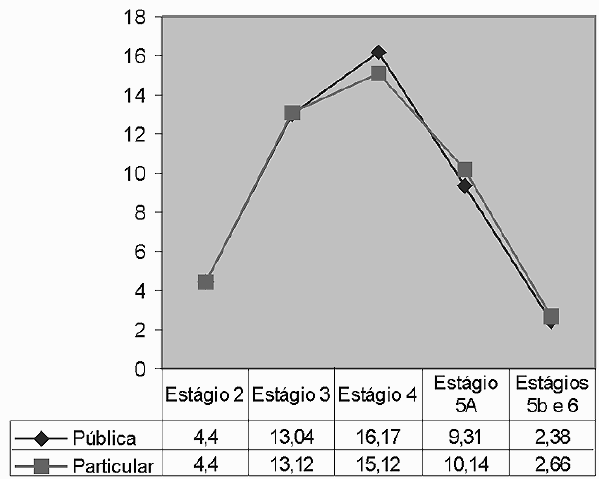
Figura 2. Pontua(cid:231)ªo mØdia bruta dos jovens brasileiros de escola pœblica e particular no